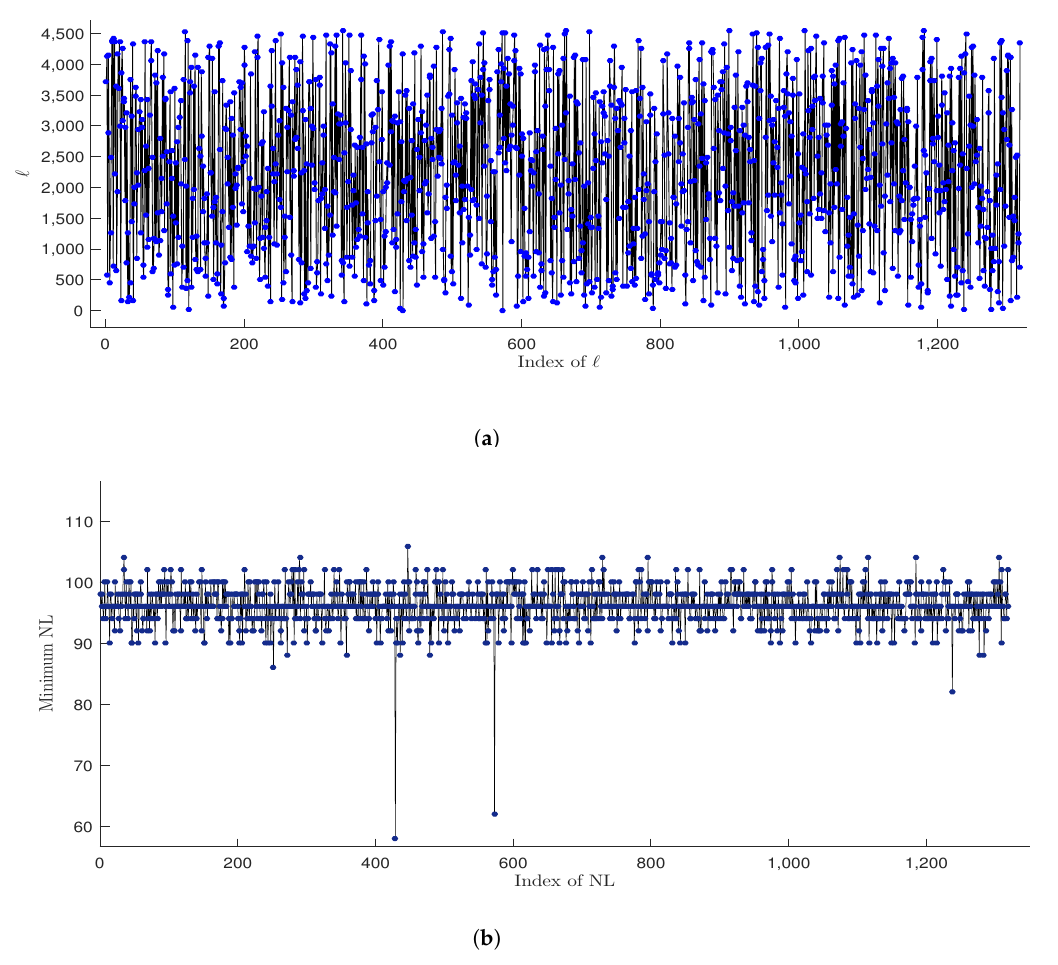
Figure 6. Illustration of distinct S-boxes: ( a ) the distribution of parameter (cid:96) ; ( b ) the oscillation of the minimum nonlinearity of the corresponding